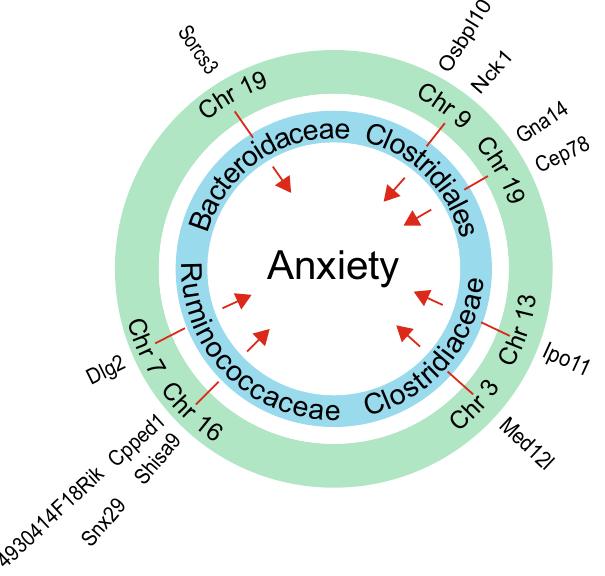
Figure 5. Microbial families mediate the effect of host genetics on anxiety. Four microbial families were identified as mediators between genetic variants and anxiety. Green ring indicates chromosomal locations associated with anxiety and abundance levels of microbial families indicated in the blue ring. Candidate genes within each genetic locus are listed on the outside of the green ring.